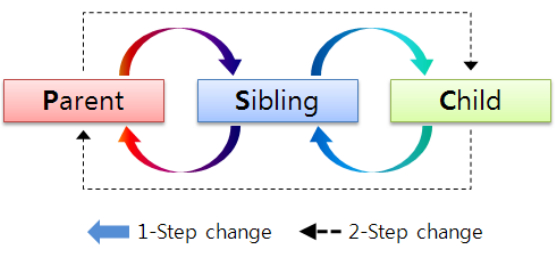
Figure 7. Relation changes between